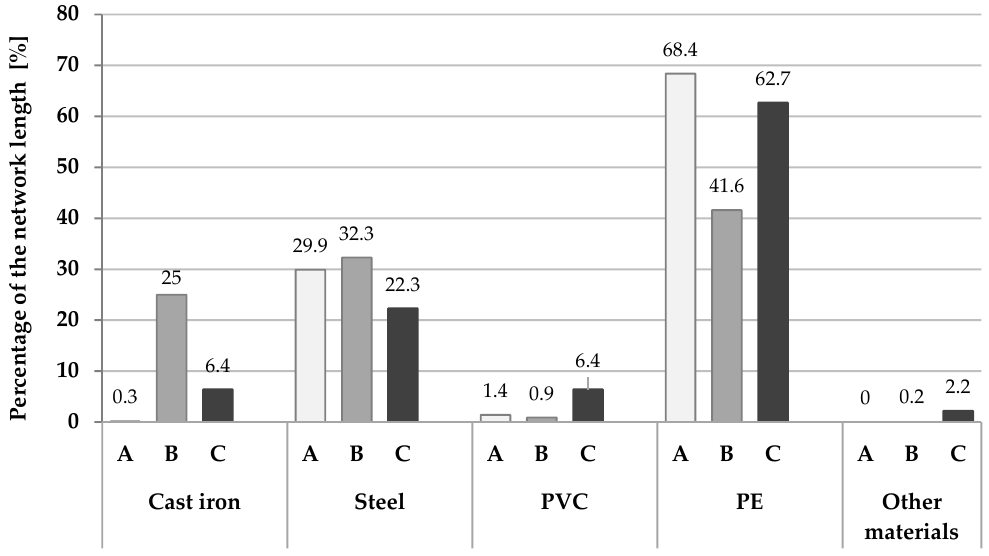
Table 3. Summary in water balance in 2013–2017.